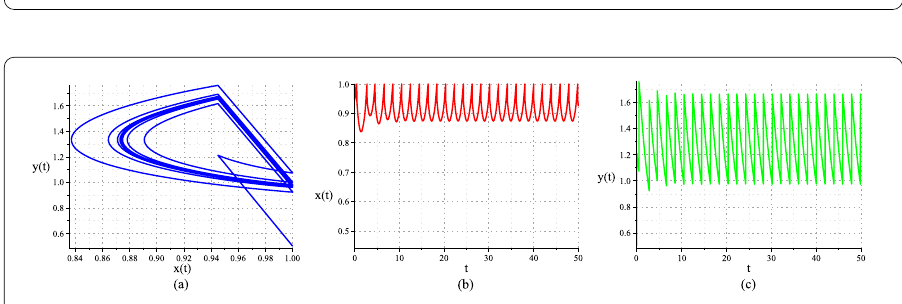
Figure 7 Numerical simulation of Example 4. (a) Phase portrait of x ( t ) and y ( t ) on h 2 = 1. (b) Time series of x ( t ). (c) Time series of y ( t